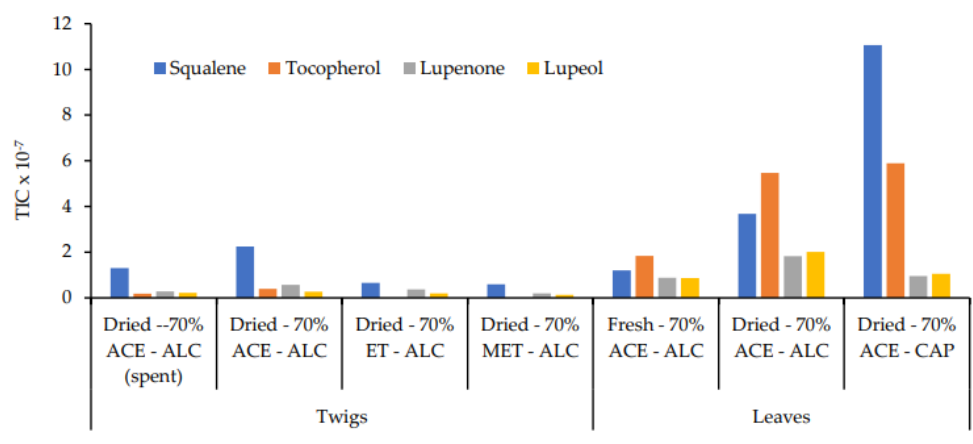
Figure 5. Absolute peak areas of squalene, α -tocopherol, lupenone (lup-20(29)-en-3-one), and lupeol in the analyzed extracts; TIC: Total Ion